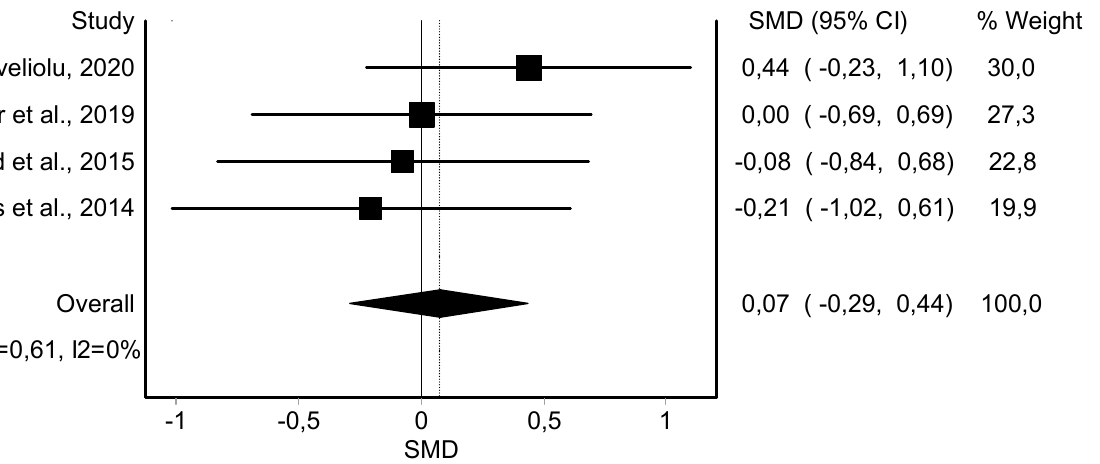
Figure 3. Synthesis forest plot of resting diastolic blood pressure variable. If the diagram (diamond- shaped) is in the negative zone (on the left of the figure and without touching the 0 line), it indicates statistically significant differences in favor of the HIIT intervention. The forest plot summarizes the results of included studies (SMD and weight). The small boxes with squares represent the point estimate of the effect size and sample size. The lines on either side of the box represent a 95% CI.